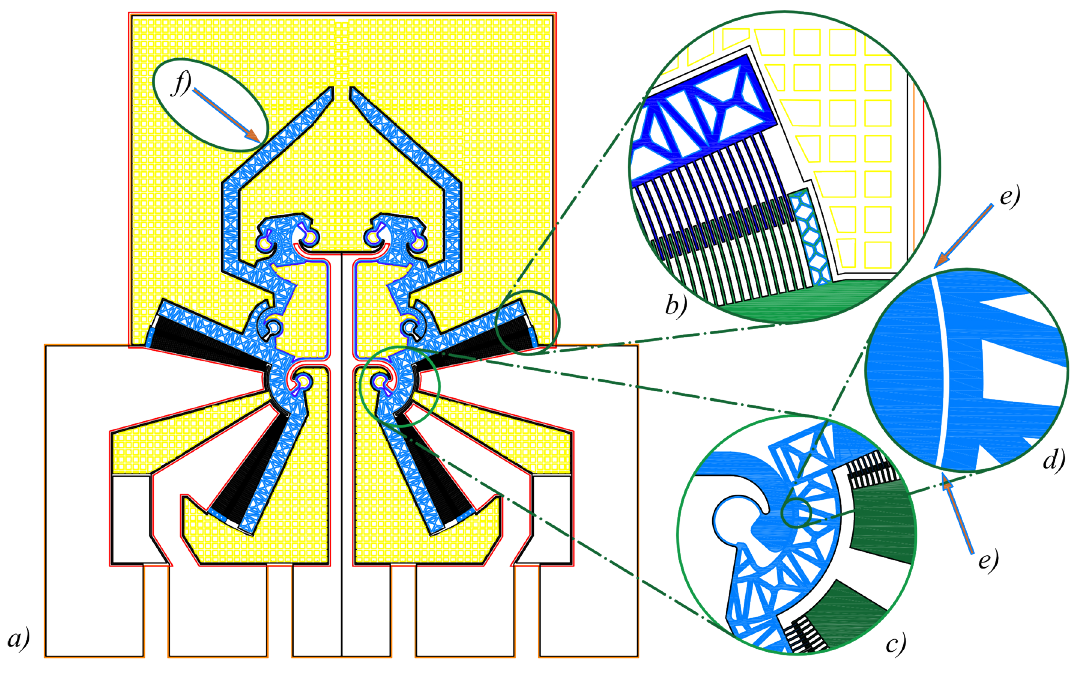
Figure 1. The mask adopted during Deep Reactive-Ion Etching (DRIE) process ( a ); details of the fingers of the comb drive ( b ); the Conjugate Surface Flexure Hinge (CSFH) hinge ( c ); the gap between the conjugate surfaces ( e ) and the left-hand side jaw ( f ).